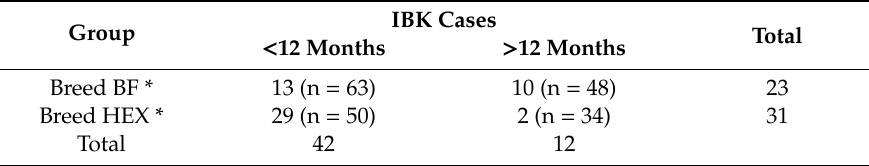
Table 2. Number of infectious bovine keratoconjunctivitis (IBK) cases by breed and age.